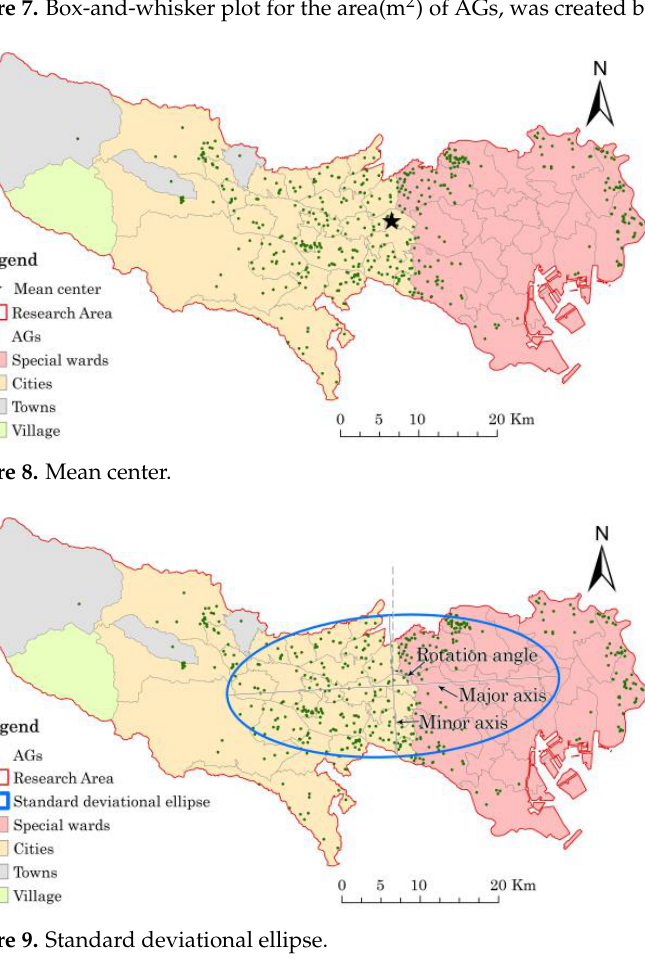
Figure 9. Standard deviational ellipse.